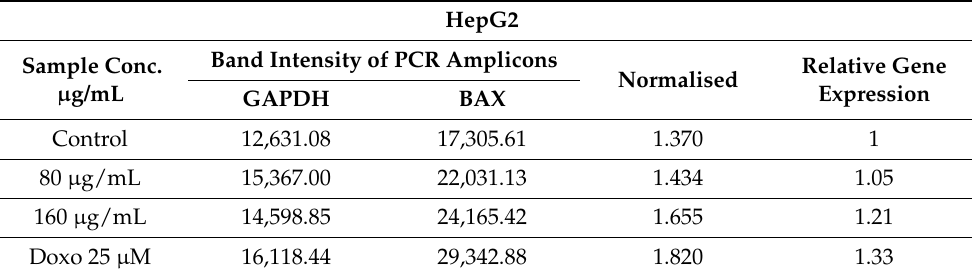
Table 6. Relative expression of BCL II gene treated with Ashwagandha in HepG2. Sample